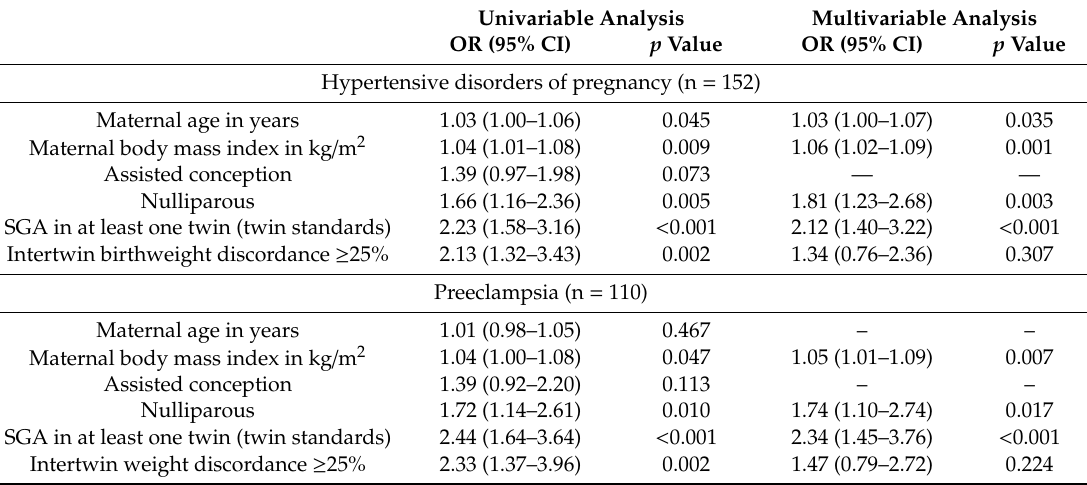
Table 5. Univariate and multivariate logistic regression analysis to identify which maternal and fetal factors are associated with hypertensive disorders of pregnancy and preeclampsia. Univariable Analysis Multivariable Analysis OR (95% CI) p Value p